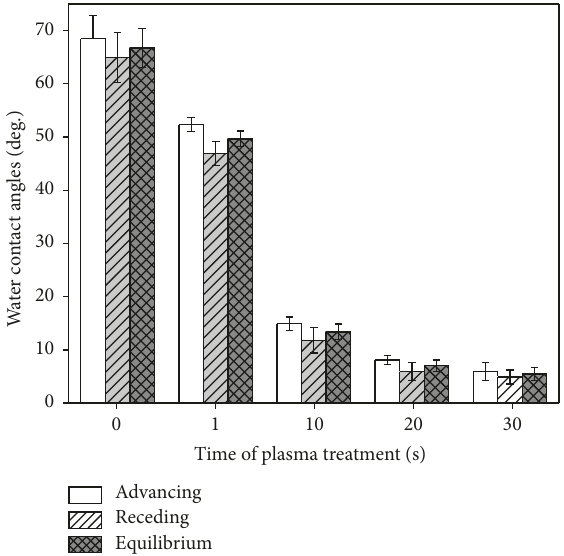
Figure5:Totalvalueofapparentsurfacefreeenergycalculatedfrom the CAH and LWAB